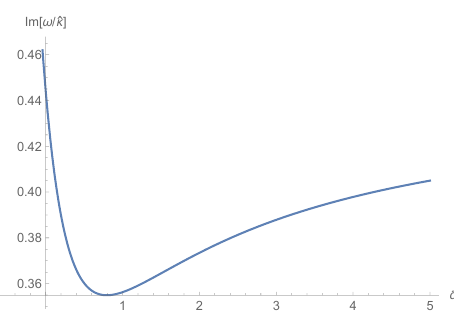
Figure 5 . Dependence of Im[ ! ‘ =0 = ^ (cid:20) ] of the EGB black ring on the GB coe(cid:14)cient ~ (cid:11) with R = 3. +